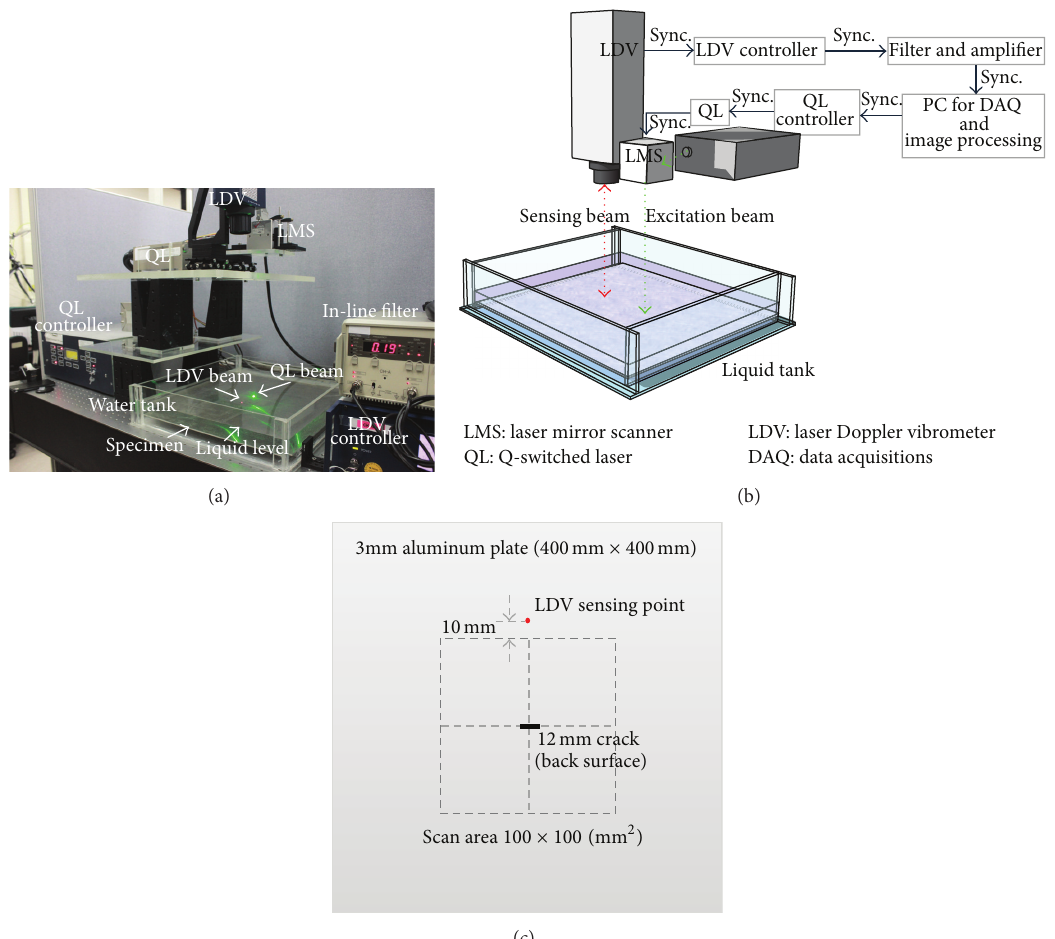
Figure 3: Experimental setup: (a) photo and (b) schematic of the UPI system for submerged structural inspection and (c) specimen with a back surface crack for